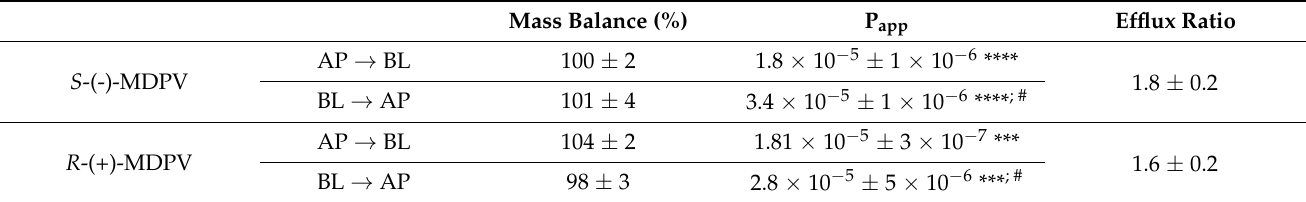
Table 5. Data obtained for mass balance, P app values, and efflux ratios expressed as mean ± SD. # p < 0.05 (between enantiomers), *** p < 0.001, **** p < 0.0001 (between